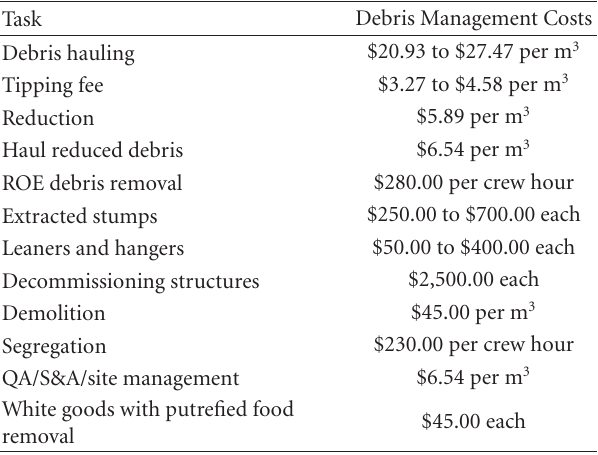
Table 2: Basic debris management costs from the AshBritt environ- mental contract